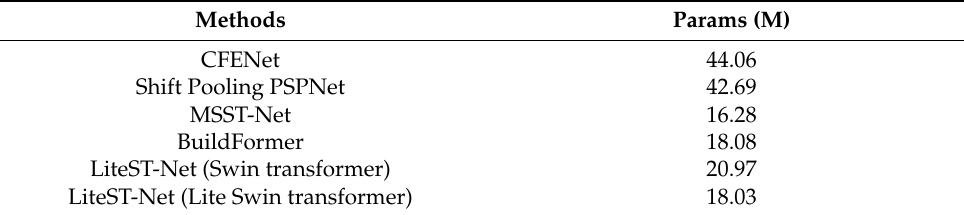
Table 3. Parameter amount of several models that perform well on the WHU building dataset.